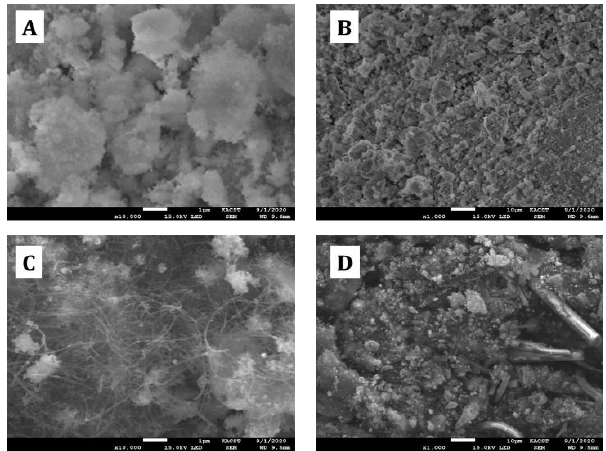
Figure 7. SEM image of ( A ) fresh 5Ni-10 La 2 O 3 -ZrO 2 catalyst, ( B ) fresh 5Ni-10 La 2 O 3 -ZrO 2 catalyst, ( C ) used 5Ni-10 La 2 O 3 -ZrO 2 catalyst, and ( D ) used 5Ni-10 La 2 O 3 -ZrO 2 catalyst.